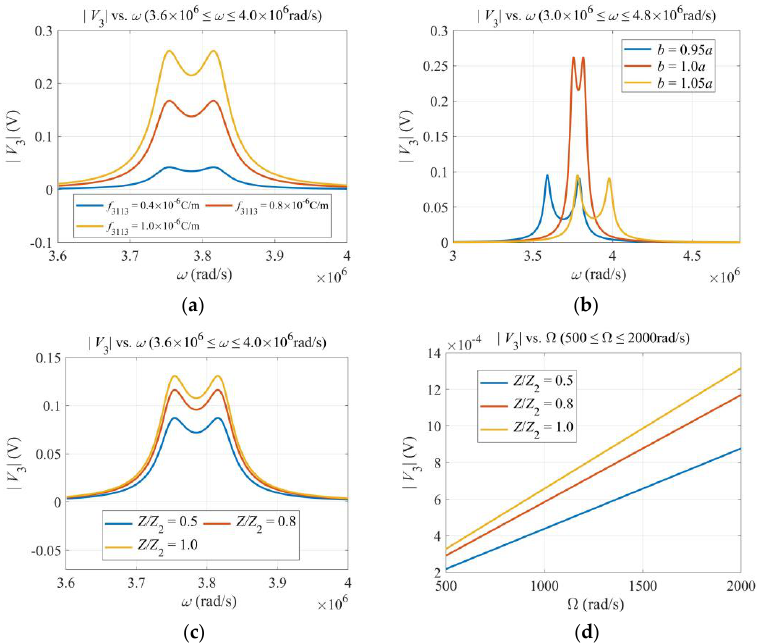
Figure 3. Effects of various parameters. ( a ) Flexoelectric coefficient. ( b ) Dimensions of the cross section. ( c ) Impedance of the output circuit. ( d ) Angular rate Ω. ω = 3.7 × 10 6 rad/s.